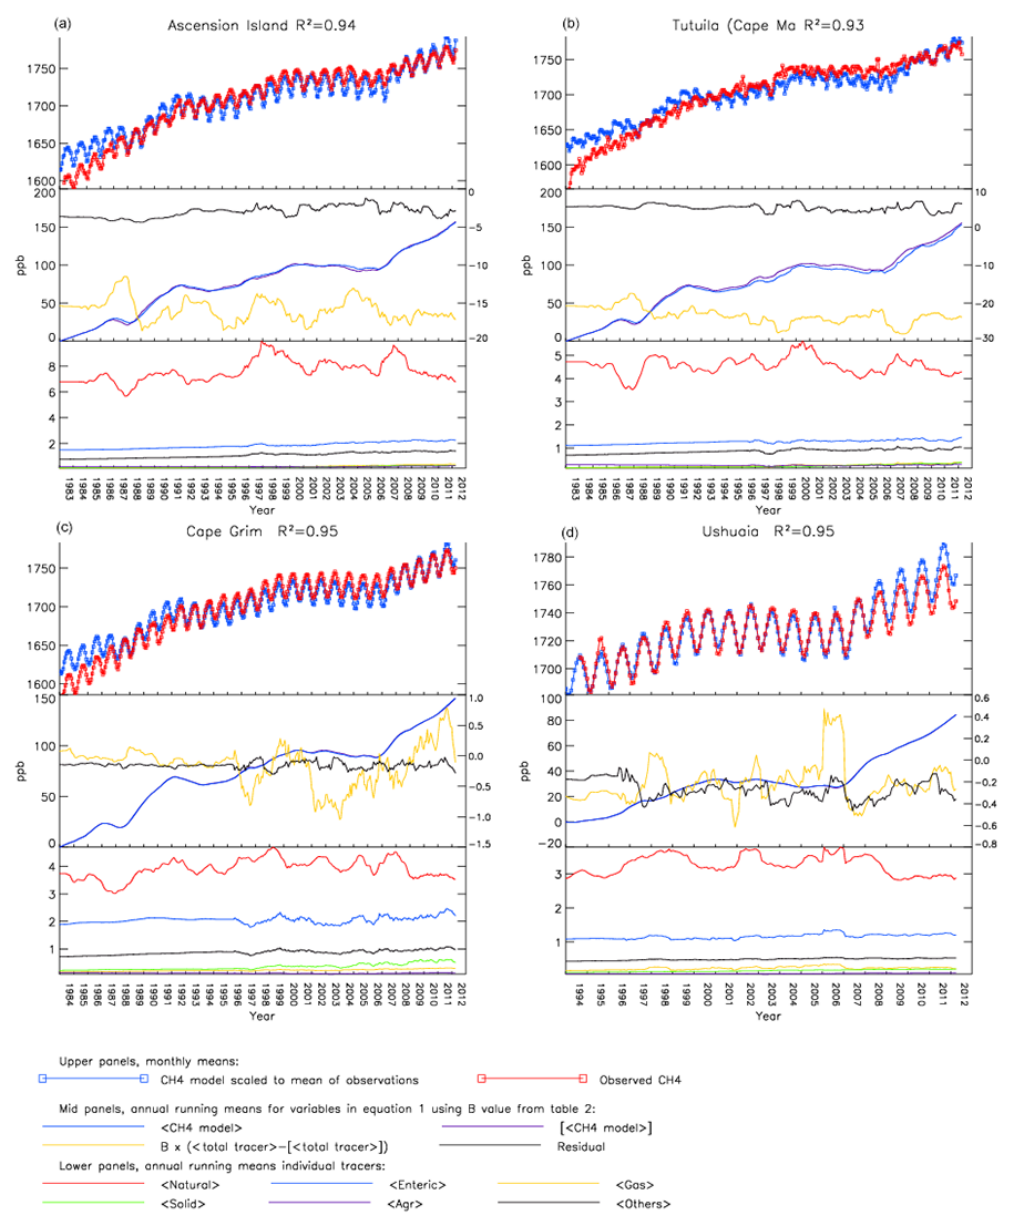
Figure 6. Evolution of CH 4 and tracers at stations ( a : Ascension Island, b : Tutuila, c : Cape Grim, d : Ushuaia) in the Southern Hemisphere. Upper panel in each figure: comparison of monthly mean surface CH 4 in model and observations. The model results are scaled to the observed mean CH 4 level over the periods of measurements. Mid panels: variables from Eq. (1). <> denotes annual running mean, [ ] denotes longitudinal mean. Left y axis: < CH 4 model > and [ < CH 4 model > ] are scaled down to be initialized to zero in the first year. Right y axis: B × (< total tracer > −[ < total tracer > ] ) and residual. Lower panels: Evolution of various emission tracers, see Table S1 in the Supplement for detailed